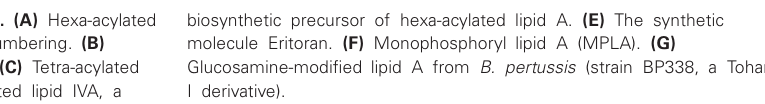
FIGURE 3 | Chemical structure of lipid A molecules. (A) Hexa-acylated lipid A from E. coli . Red numbers indicate carbon numbering. (B) Hexa-acylated lipid A from Y. pestis grown at 27 ◦ C. (C) Tetra-acylated lipid A from Y. pestis grown at 37 ◦ C. (D) Tetra-acylated lipid IVA, a